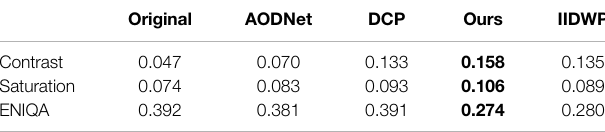
Bold values indicate the best values.